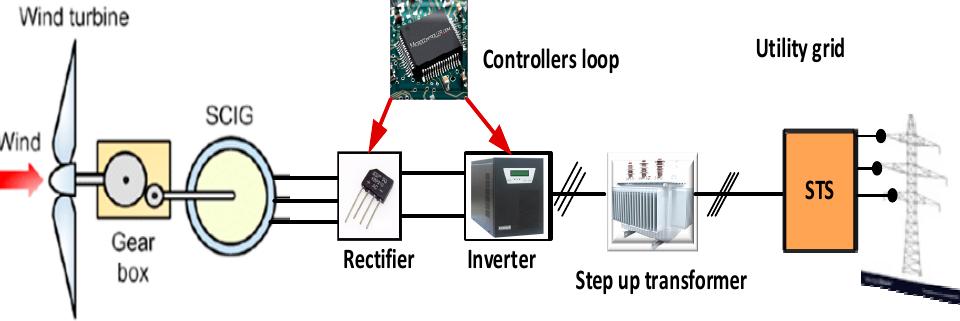
Figure 6. Schematic diagram of a wind turbine (WT) based synchronous generator with full